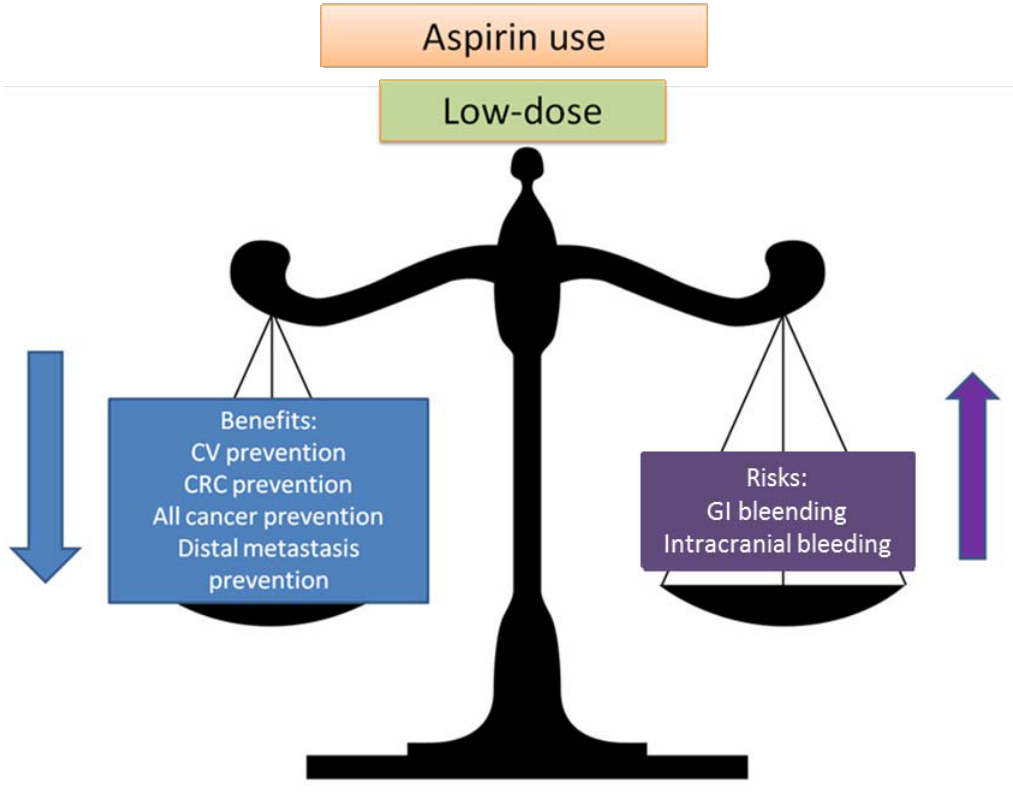
Figure 1. Balancing risks and benefits of aspirin